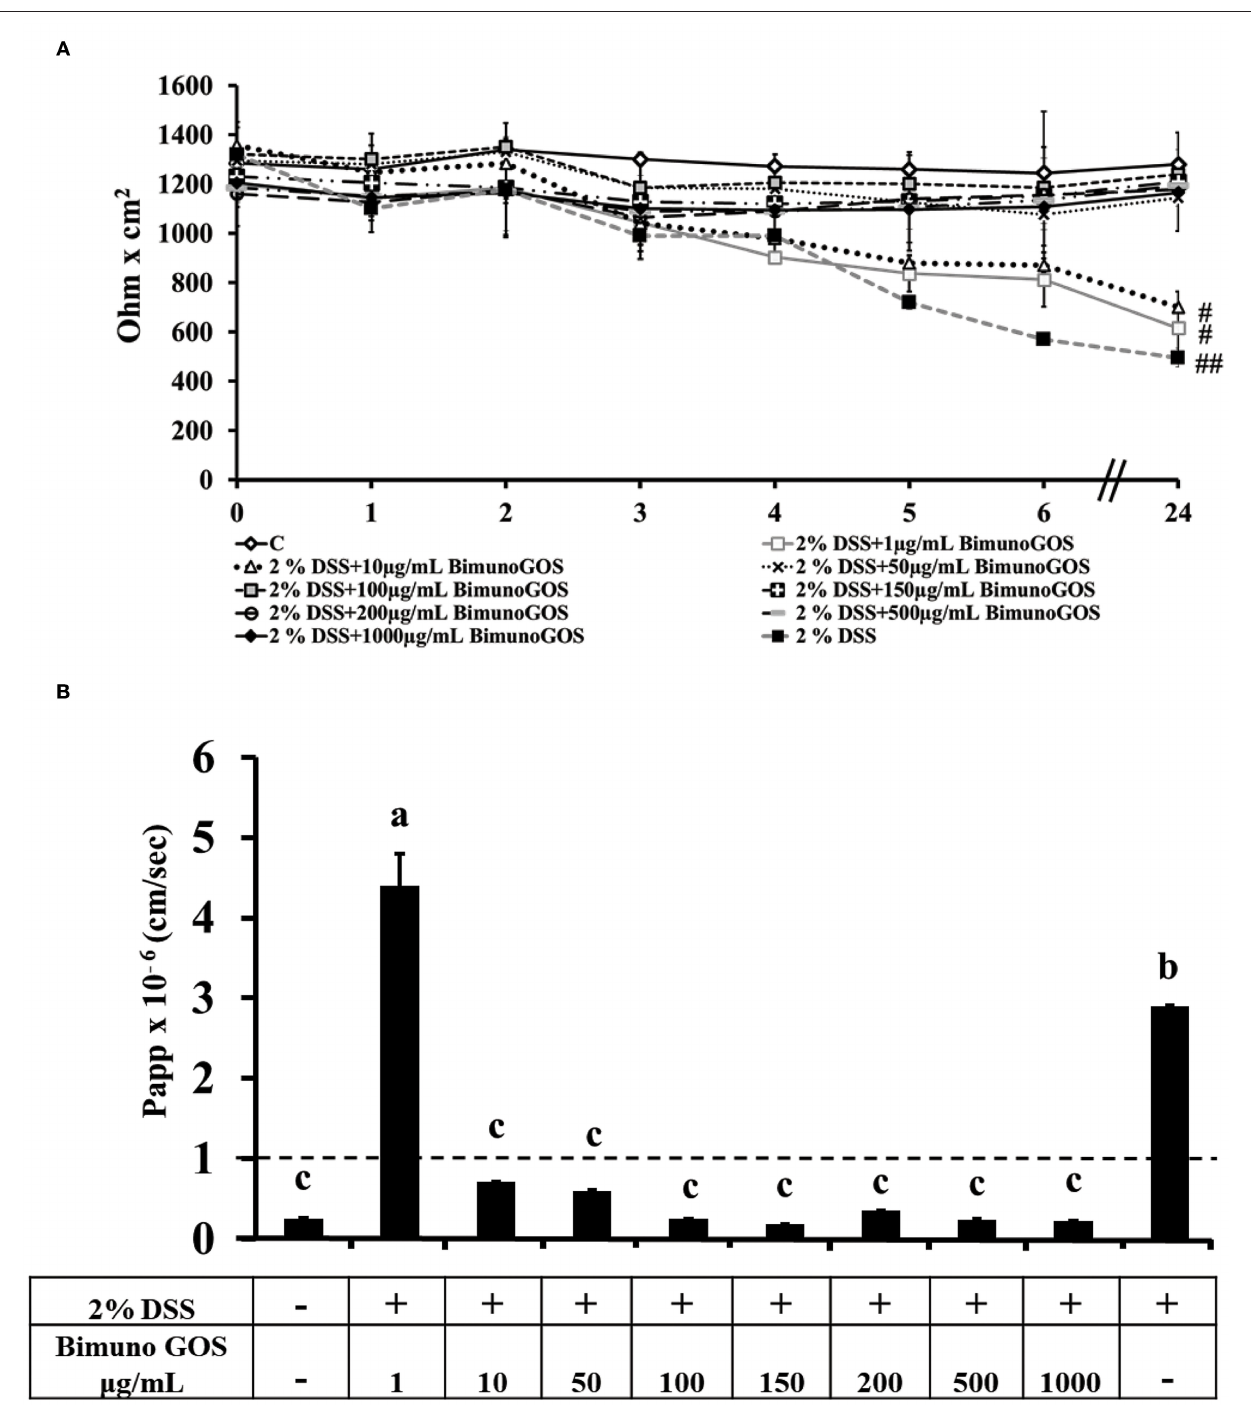
FIGURE 4 | Protective effect of Bimuno GOS against membrane barrier damages induced by DSS in Caco-2 cells. Transepithelial electrical resistance (TEER) (A) and phenol red apparent permeability (Papp) (B) . Cells were either untreated (C) or treated with 2% DSS for 2h and then with several Bimuno GOS concentrations (1–1,000 µ g/ml) up to 24h. TEER values are reported as Ohm × cm 2 . Phenol red Papp values are reported as cm/s. Values represent mean ± SD of at least three independent experiments, carried out in triplicate. (A) # , ## Stand for significant difference between T0 and T24 ( P < 0.01 and P < 0.001, respectively). Values represent mean ± SD of at least three independent experiments, carried out in triplicate. (B) Means without a common letter significantly differ, P < 0.05.